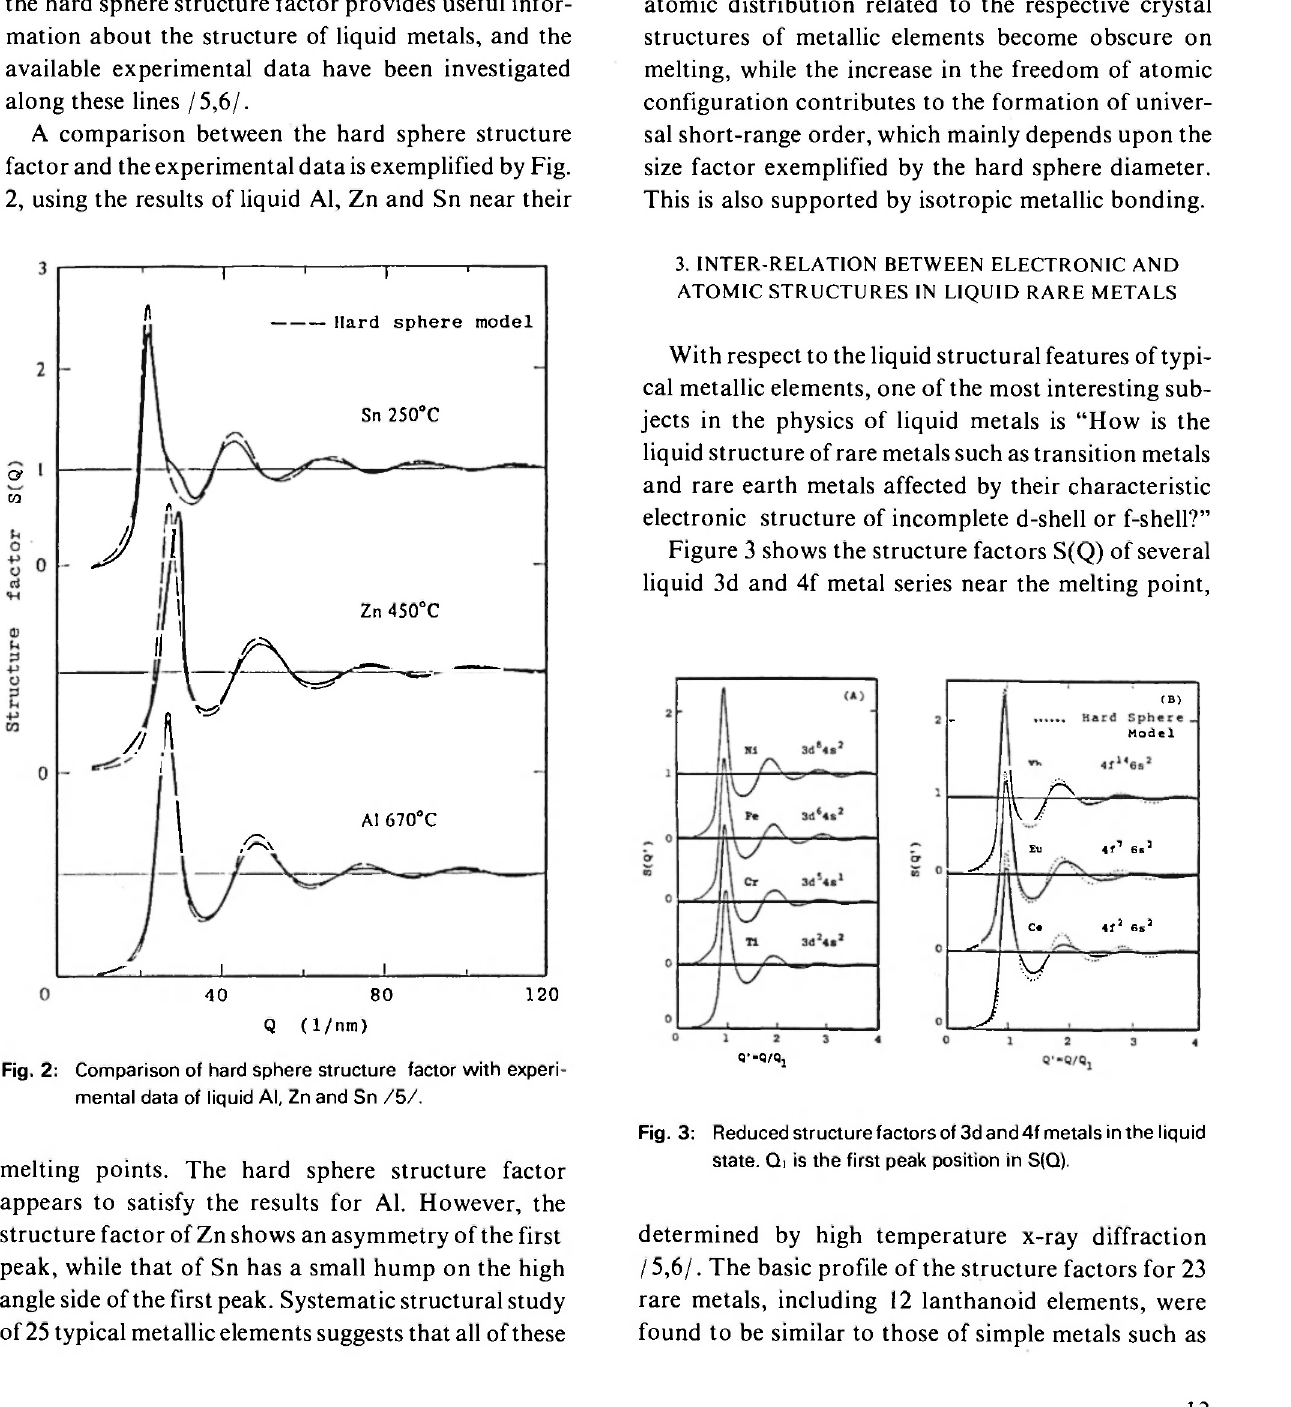
Fig. 2: Comparison of hard sphere structure factor with experi- mental data of liquid Al, Zn and Sn /5/.